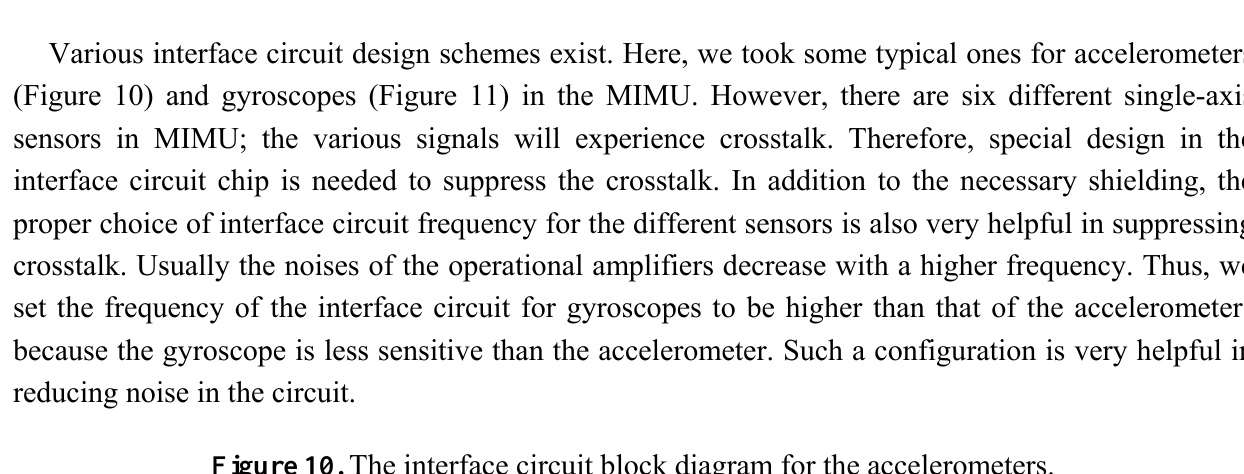
Figure 10. The interface circuit block diagram for the accelerometers.